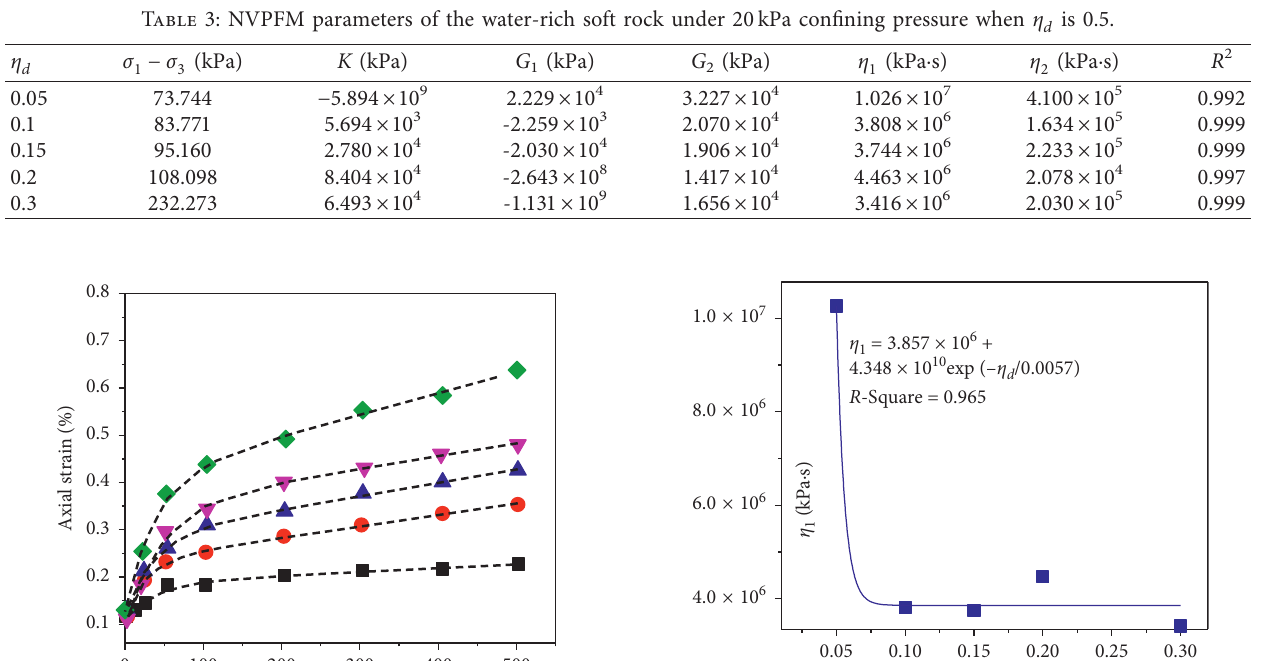
Figure 14: NVPFM curve of the water-rich soft rock [52] under 200kPa confining pressure when fatigue breakdown does not occur.